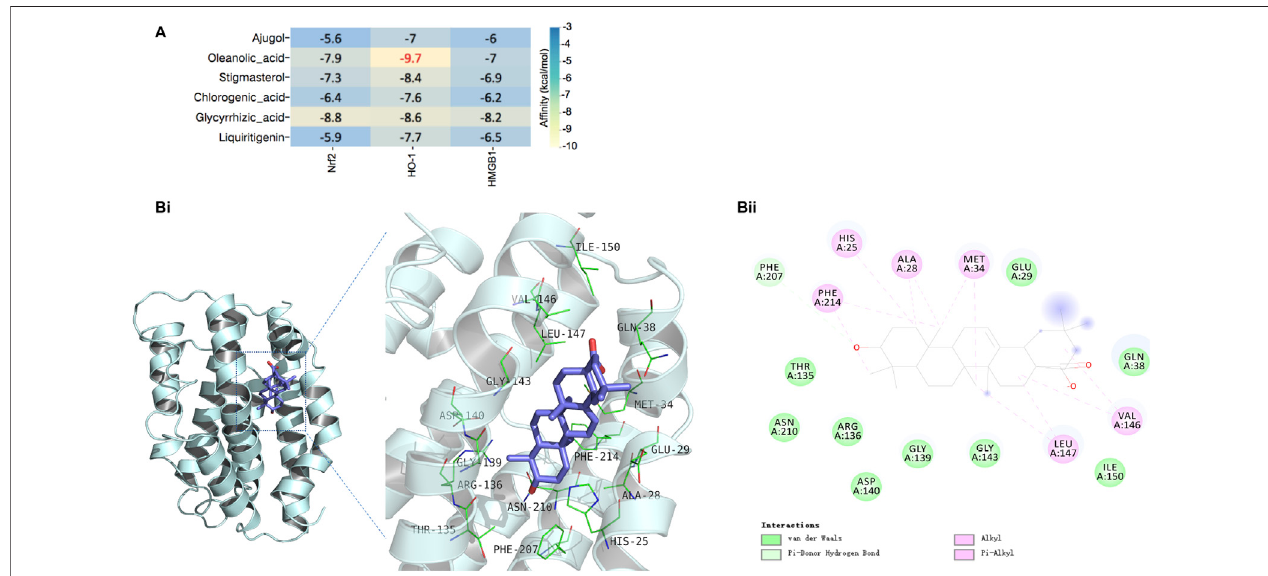
FIGURE 6 | Interactions and potential binding modes of DCP components and the targets Nrf2, HO-1 and HMGB1. (A) : The docking score of the detected DCP components in rat tissues with the targets of Nrf2, HO-1 and HMGB1. (Bi,Bii) : Representative 3D binding model of oleanolic acid to HO-1(Bi), and representative 2D model of the binding